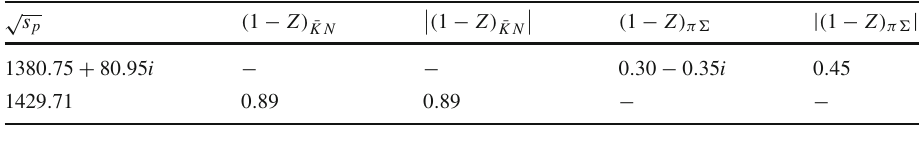
Table 8 Radii of the poles evaluated with Eq. (17) in single channel approach